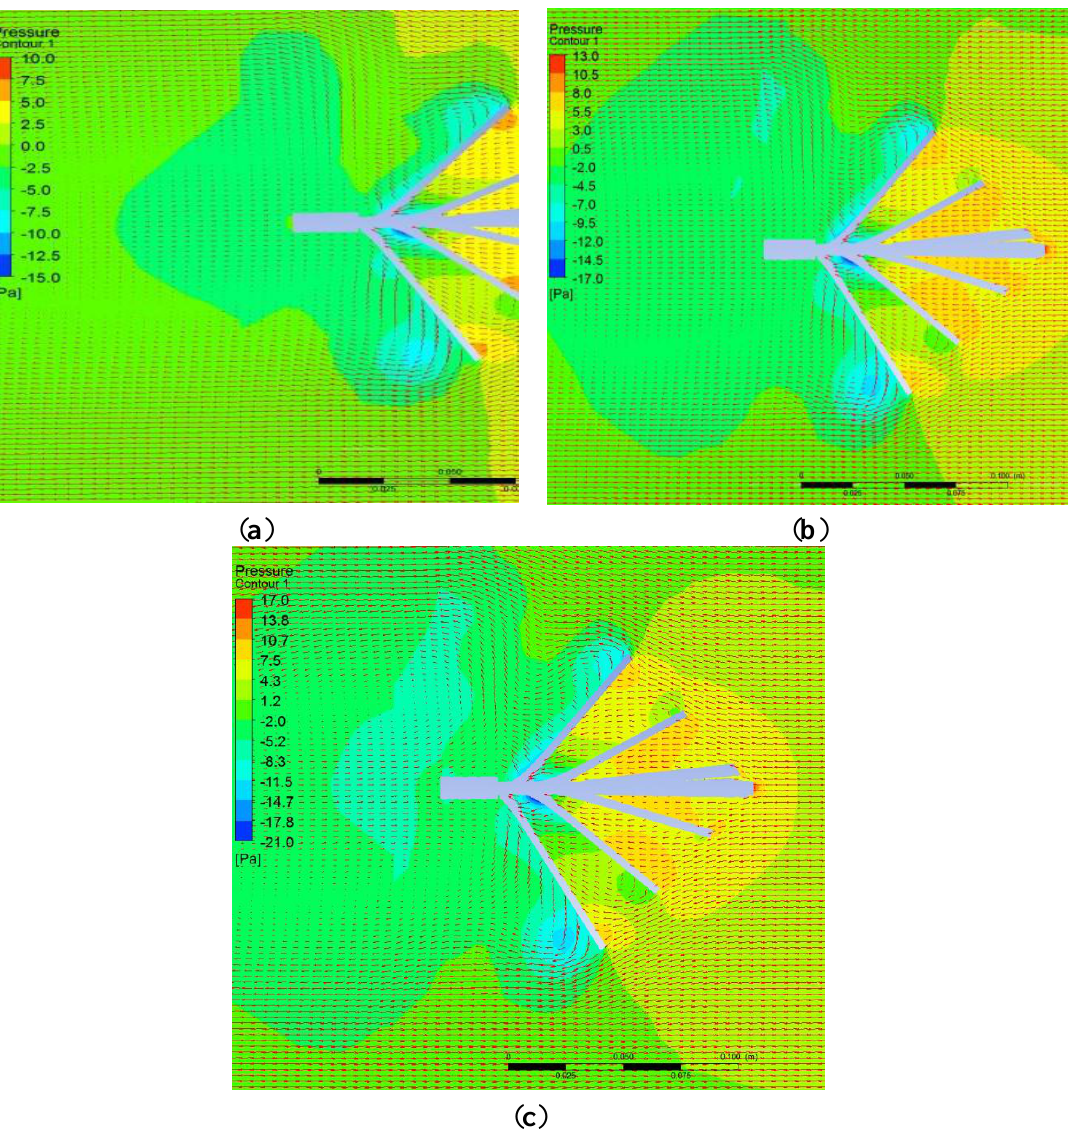
Figure 9. Static pressure distribution obtained by the steady simulation ( a ) 3.5 m/s